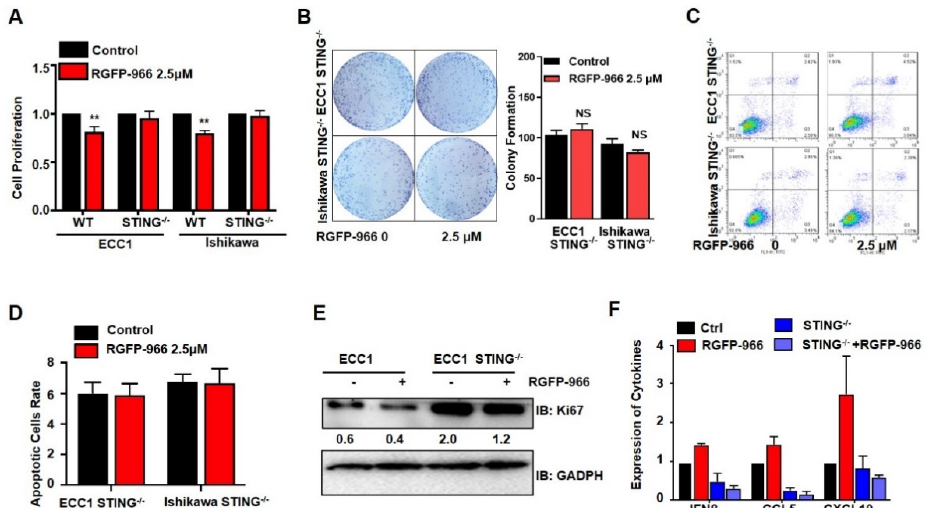
Figure 6. STING is critical for the antiproliferation and pro-apoptotic function of HDAC3 inhibition. ( A ) CCK8 analysis of ECC1 cells WT or STING − / − and Ishikawa cells WT or STING − / − treated with 2.5 μ M RGFP-966 for 48 h. ( B ) Colony formation analysis of ECC1 and Ishikawa cells transfected with 2.5 μ M RGFP-966. ( C ) Flow cytometry analysis of ECC1 cells WT or STING − / − and Ishikawa cells WT or STING − / − treated with 2.5 μ M RGFP-966 for 48 h. ( D ) Apoptotic analysis of ECC1 cells WT or STING − / − and Ishikawa cells WT or STING − / − treated with 2.5 μ M RGFP-966 for 48 h. ( E ) IB analysis of WCL derived from ECC1 cells WT or STING − / − and Ishikawa cells WT or STING − / − treated with 2.5 μ M RGFP-966 for 48 h. ( F ) qPCR analysis of cytokines from ECC1 cells WT or STING − / − and Ishikawa cells WT or STING − / − treated with 2.5 μ M RGFP-966 for 48 h. The cell-based experiments were repeated at least three times and representative results are shown as mean ± SD. Two-way ANOVA analyses were used to calculate the p -value. ** p < 0.001, significantly different from control. Original image of Western blot can be found in File S1.